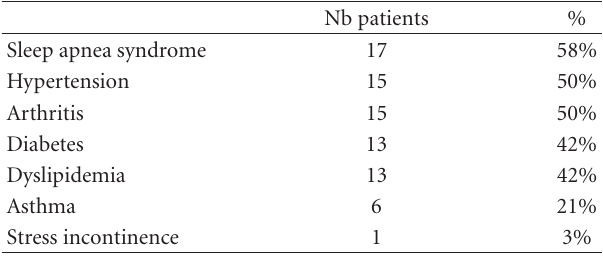
Table 1: Co-morbidities of the 30 super superobese